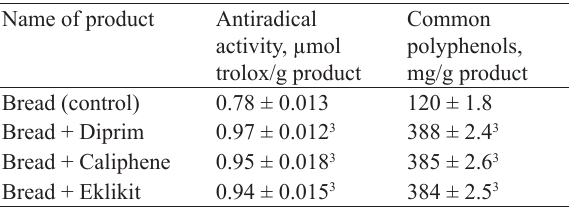
Table 1 Antiradical activity and common polyphenols in the breads (M ± m) Name of product